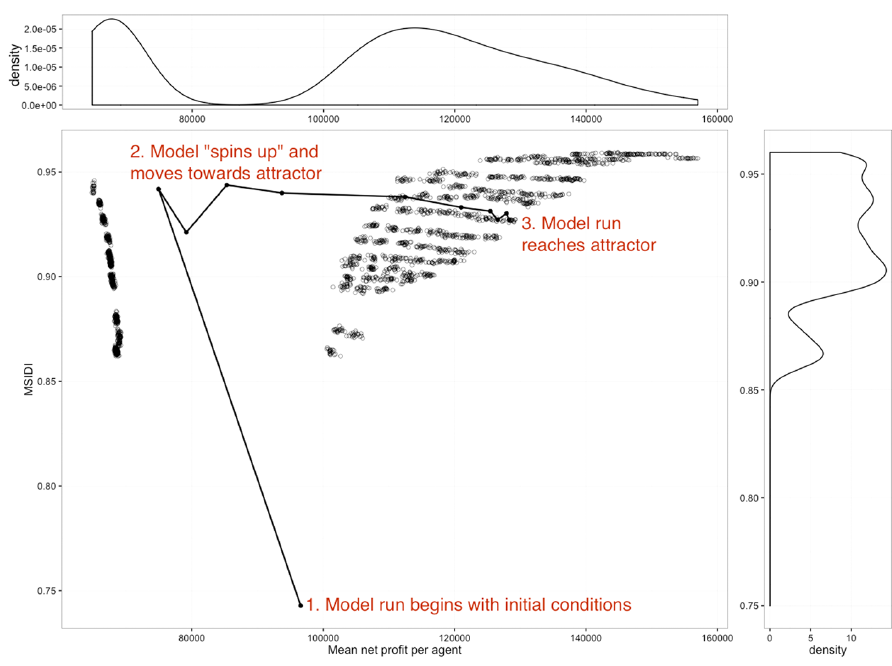
Fig. 3 . A single trace of a model run through state space (solid line) overlaid with outcomes of other model runs (open circles) that result from the grid search of input parameters. Two distinct attractors are found in this state space, with smaller attractors nested within each. (MSIDI: Modified Simpson Diversity